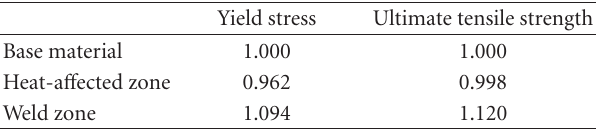
Table 4: Normalized mechanical properties of Hastelloy-X alloy in the weld